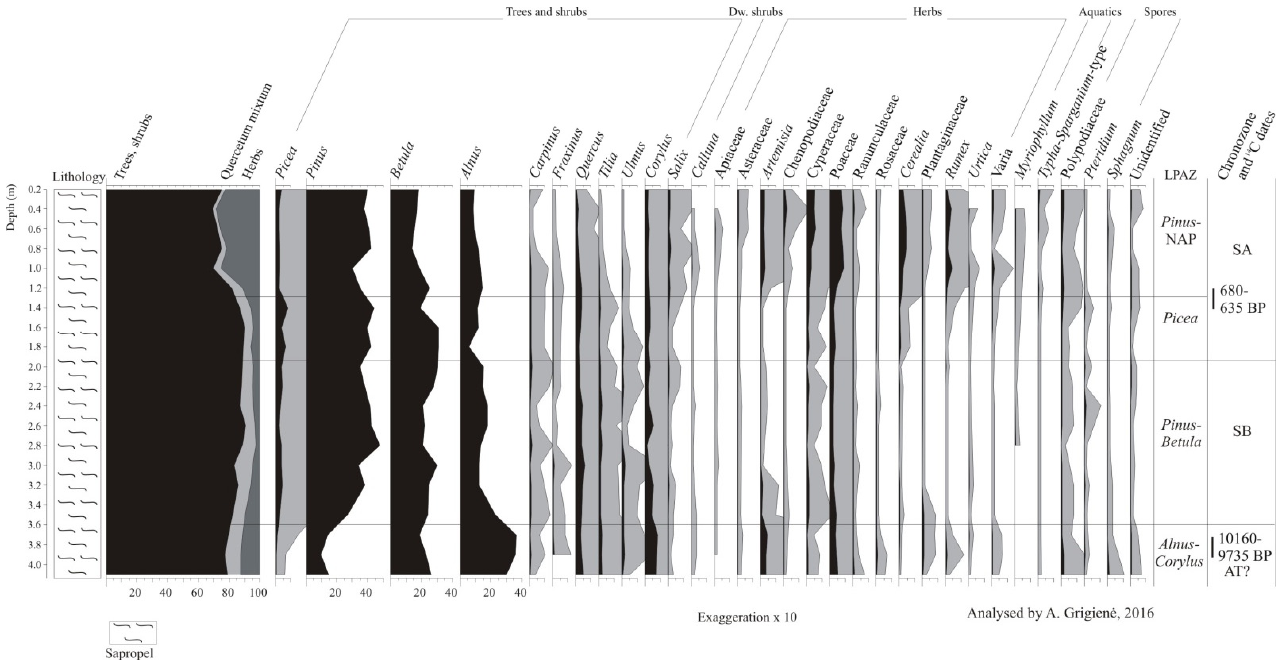
Figure 5. Percentage pollen diagram of the core from Lake Didžiulis.